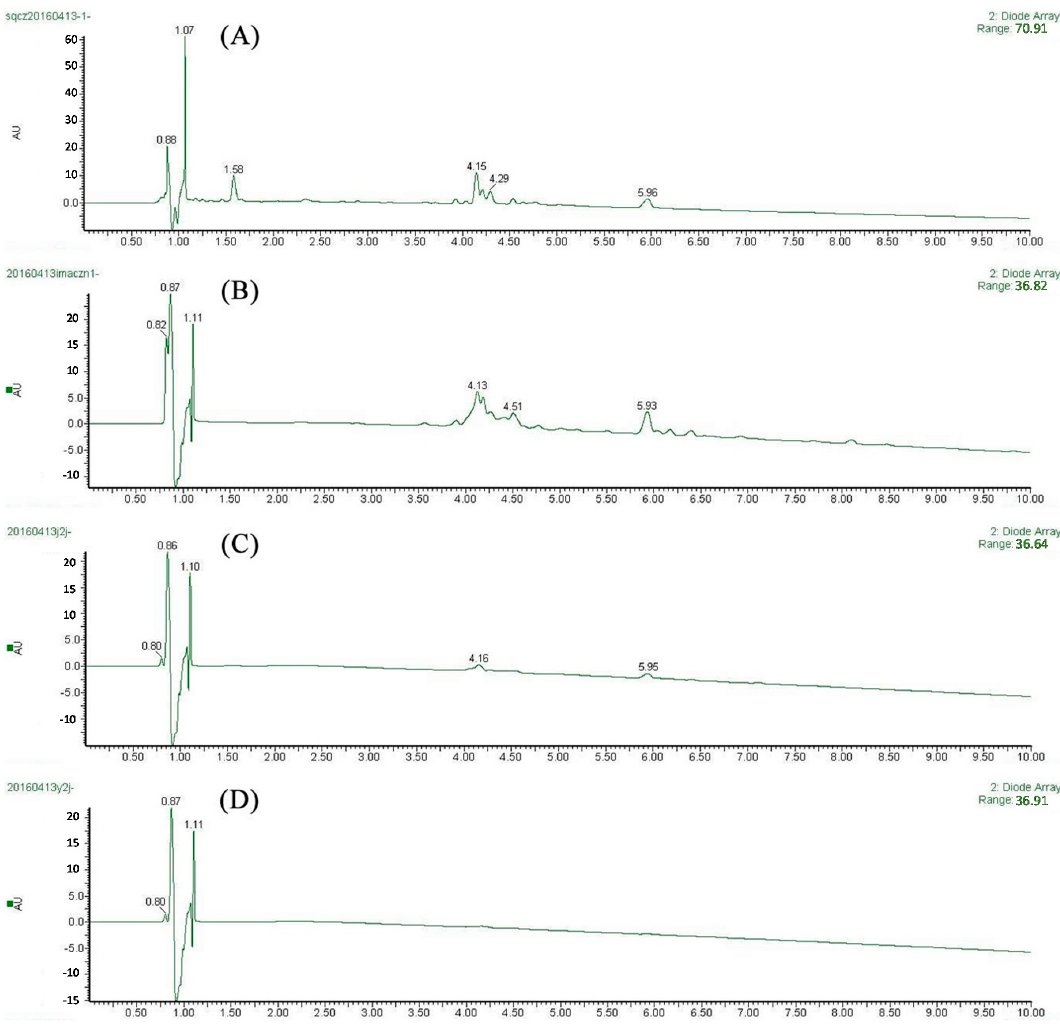
Figure 2. The UPLC chromatogram of G. hypoleucum extract ( A ) and IMAC 1% HCl-MeOH eluent ( B ) monitored at 250 nm; The UF-UPLC-MS method approach for screening selective ligands to XOD from IMAC-Zn 1% HCl-MeOH eluent ( C ) and G. hypoleucum extract ( D ).